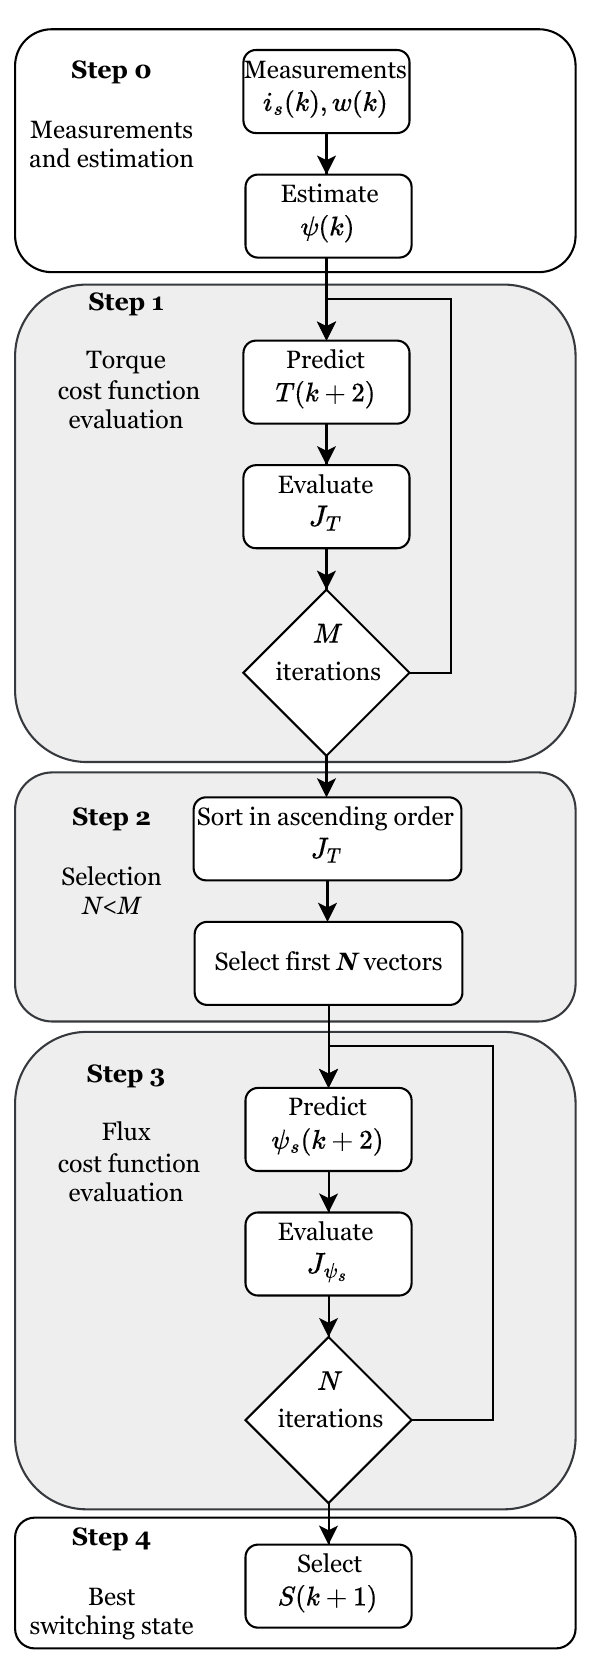
Figure 4. Flow diagram of the sequential model predictive control (SMPC) with 2 cost